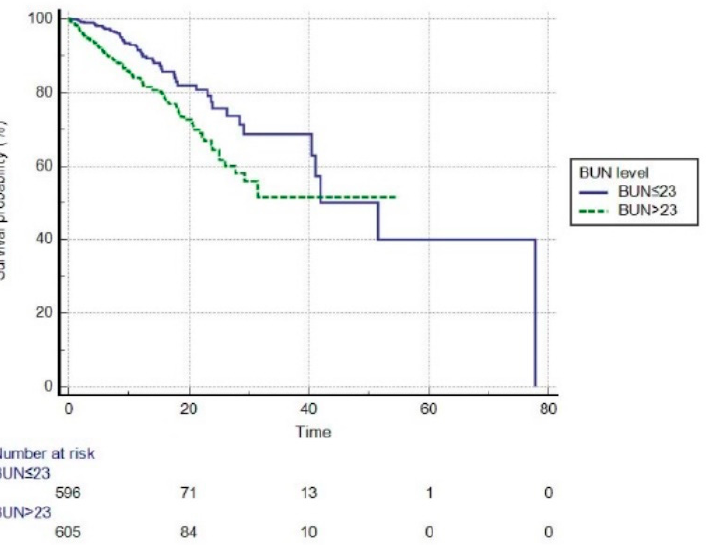
Figure 3. The Kaplan–Meier survival curve of high and low BUN groups (before propensity score matching, log-rank p < 0.001). BUN, blood urea nitrogen (mg/dL).